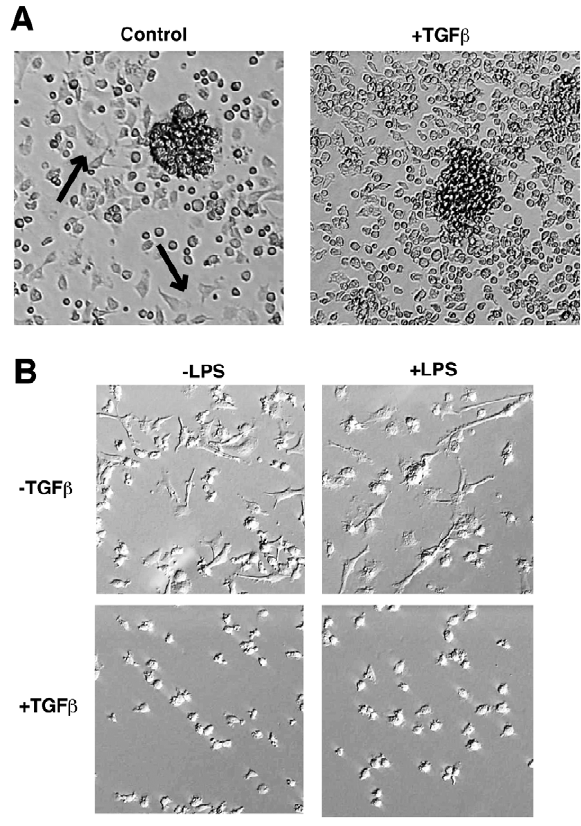
Figure 5. TGF- b Directly Alters DC Morphology. (A) Day 5 BMDCs cultured in the presence or absence of TGF- b were visualized for both cell cluster formation and cell morphology by microscopy. Arrows indicate cells that have spread onto the tissue culture surface. These cells are not apparent in TGF- b cultures. (B) CD11c + cells cultured as in (A) were purified/mechanically-stimulated with magnetic beads and re- plated in medium with or without 100 ng/ml LPS. Twenty four hours after stimulation cells were analyzed by microscopy. Note the cytoskeletal activation and cell spreading in control DCs that is absent in TGF- b DCs, even when stimulated by LPS. White arrows in upper panels indicate punctate actin staining. All images are representative of at least 3 independent